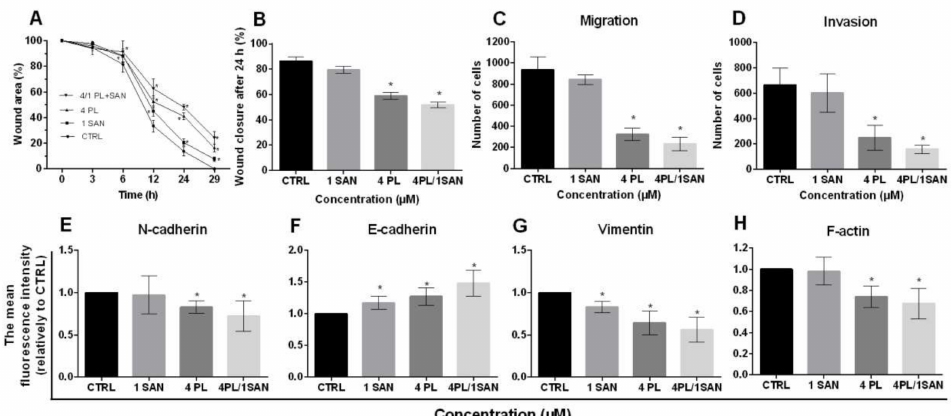
Figure 9. The e ff ects of piperlongumine (PL) and sanguinarine (SAN) individually and in a combined treatment on the migration and invasion potentials of A549 cells. Wound-healing assay ( A ). The process of growing the surface “wound” after 0, 3, 6, 12, 24 and 29 h following the addition of 4- µ M PL, 1- µ M SAN and their combination in ratio 4:1. ( B ) The percentage of the surface of the wound area 24 h after mechanical scratching. Data represent the mean ± SD obtained from 3 independent replicates ( n = 3). Statistically significant di ff erences in comparison to the untreated cells were marked as * ( p < 0.05; two-way ANOVA). Migration ( C ) and invasion assay ( D ). The average number of cells located on the outside of the insert. Data represent the mean ± SD obtained from 4 independent replicates ( n = 4). Statistically significant di ff erences in comparison to the untreated cells were marked as * ( p < 0.05; Kruskal-Wallis with Dunn’s post hoc test). The cytometric analysis of the epithelial-to-mesenchymal transition (EMT)-related proteins N-cadherin ( E ), E-cadherin ( F ), vimentin ( G ) and F-actin ( H ). The results are presented as the fold of the results obtained for the CTRL (estimated as 1). Data represent the mean ± SD obtained from 4 independent replicates ( n = 4). Statistically significant di ff erences in comparison to untreated cells were marked as * ( p < 0.05; Wilcoxon